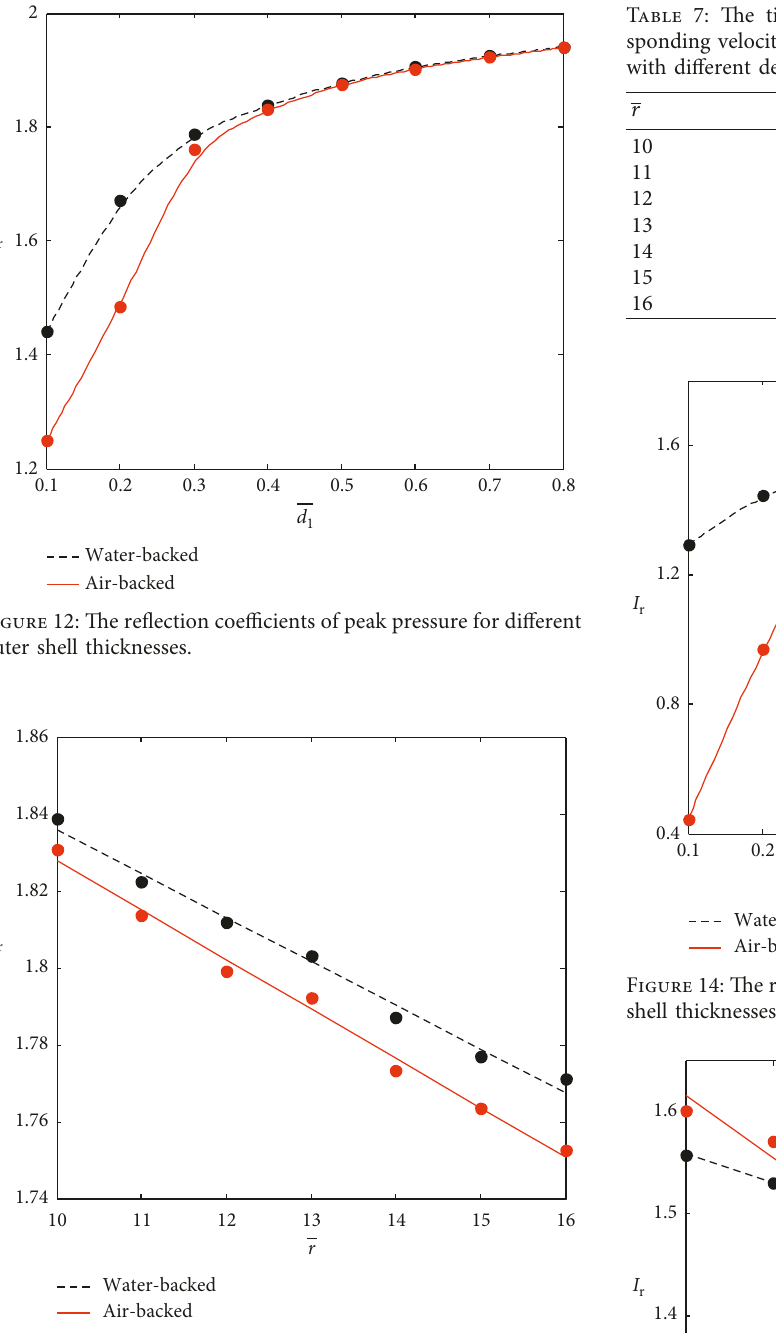
Figure 13: The reflection coefficients of peak pressure for different detonation distances.